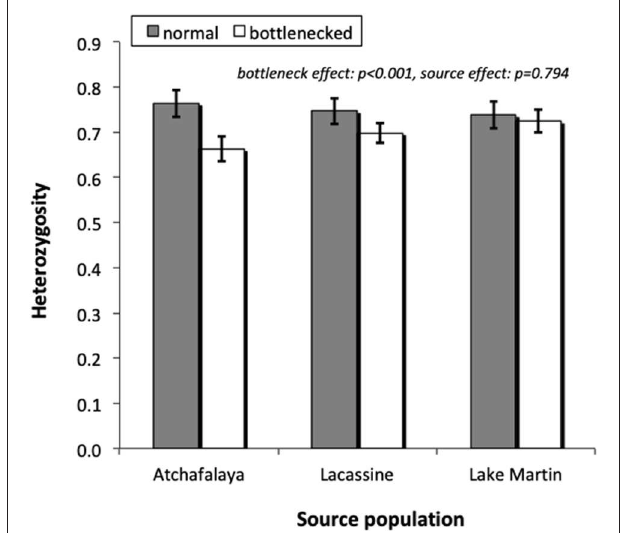
FIGURE 2 | Heterozygosity (based on Hardy Weinberg expectations), for microsatellite loci, of normal and bottlenecked laboratory populations derived from three different source populations. Values are mean ± S.E. ( N = 7